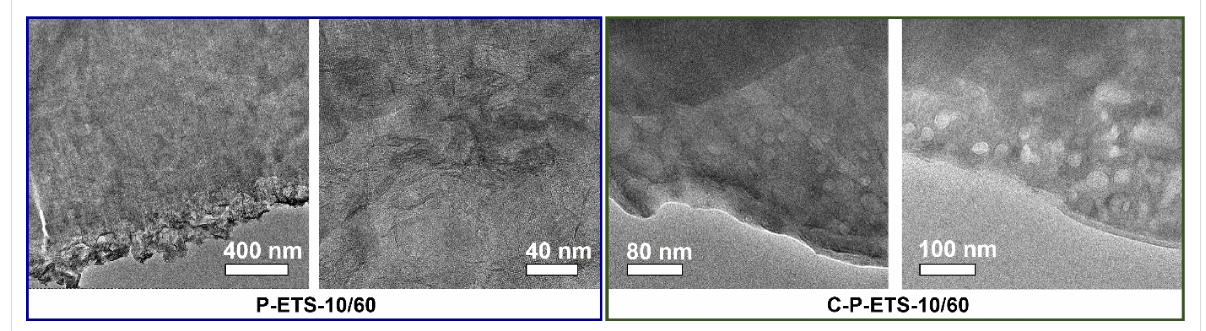
Figure 10: TEM images of the selected crystals of P-ETS-10/60 and C-P-ETS 10/60 demonstrating the presence of mesopores that appeared after treatment.